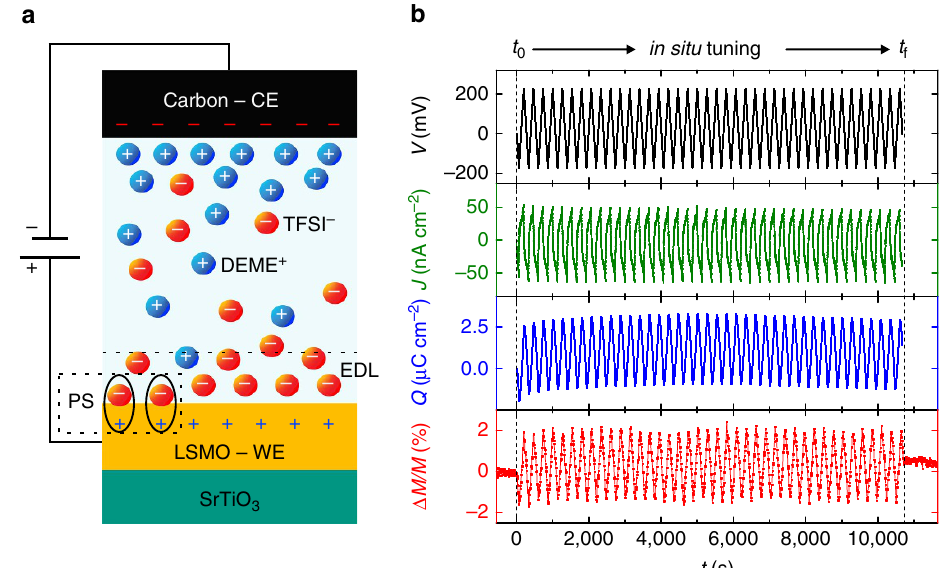
Figure 1 | Sketch of the device and in situ measurement principle. ( a ) Schematic of the electrochemical tuning cell: a La 0.74 Sr 0.26 MnO 3 (LSMO) single- crystal thin film ( E 13nm) grown on a SrTiO 3 substrate and a high-surface-area carbon cloth serve as working (WE) and counter (CE) electrodes, respectively. The electrodes are separated by an insulating glass fibre (not shown). On application of an external voltage, the ions of the ionic liquid (DEME þ -TFSI (cid:2) ) form physical or chemical bonds with the LSMO surface leading to electrostatic (electric-double-layer (EDL) capacitance) or electrochemical (pseudocapacitance (PS)) charge carrier doping, respectively. Both mechanisms allow for manipulating the magnetic state of LSMO. ( b ) Example of in situ tuning experiment performed at 323K: the magnetic response (in red) reversibly follows the surface charge modulation (in blue), calculated by integrating the measured current density (in green), on repetitive cycling of the external potential (in